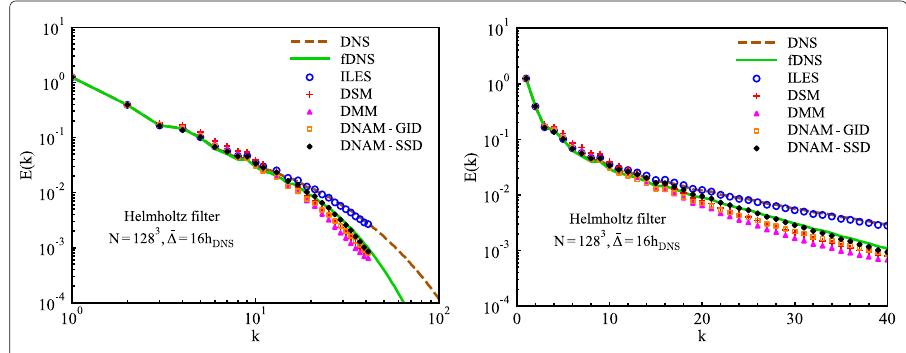
Fig. 13 Velocity spectra with the Helmholtz filter in aposteriori study at filter scale 16 h